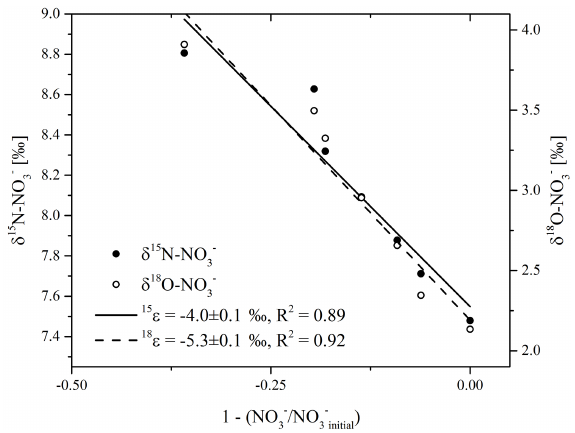
Figure 5. Dual nitrate isotope values vs. the remaining fraction of nitrate corresponding to the filled data points in Fig. 1b and c. The solid line indicates the apparent isotope effect during net nitrate con- sumption with a slope of 15 ε − 4.0 ± 0.1‰ with R 2 of 0.89 and the dashed line is 18 ε − 5.3 ± 0.1‰ with R 2 of